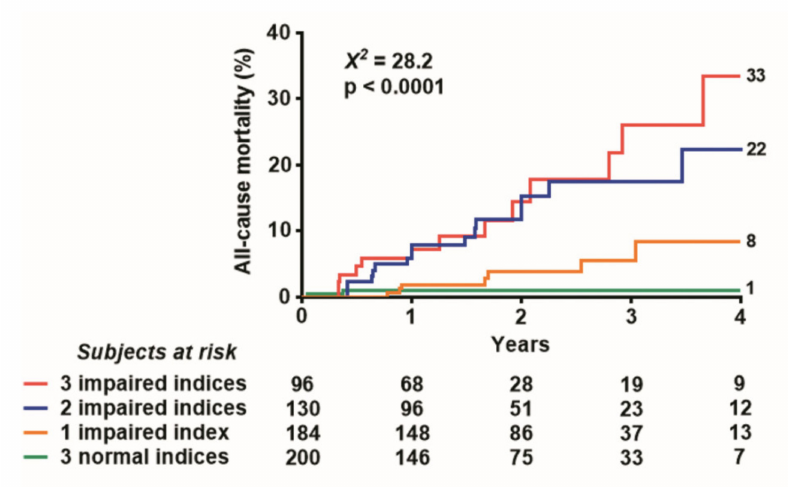
Figure 5. Event-free Kaplan–Meier survival curves. The five-year event-free survival is lowest in patients with the highest SE